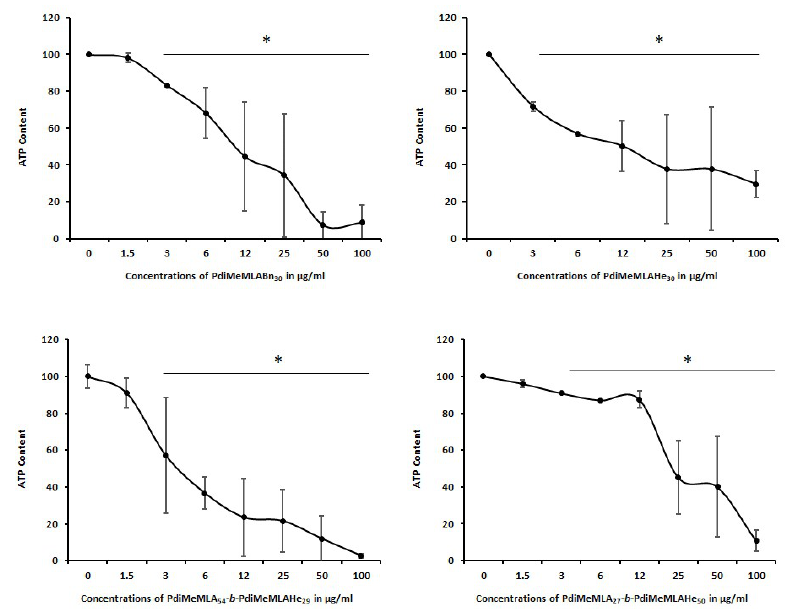
Figure 5. Progenitor HepaRG cell viability evaluated by measuring the ATP content at 24 h of incubation with increasing concentrations of (co)polymers PdiMeMLA 54 - b -PdiMeMLAHe 29 , PdiMeMLA 27 - b -PdiMeMLAHe 50 , PdiMeMLABn 30 and PdiMeMLAHe 30 NPs. Statistics: * p < 0.05 for treated cultures versus untreated control cultures (0).